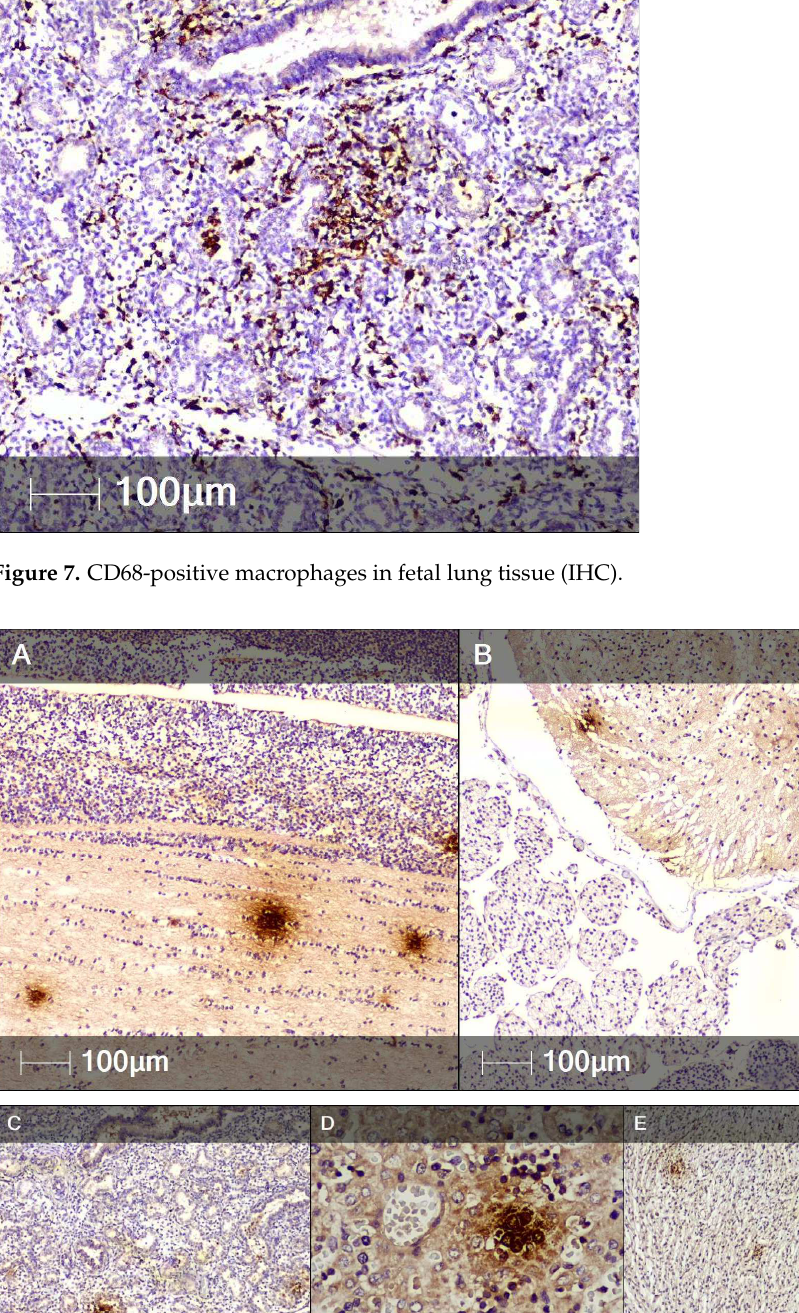
Figure 7. CD68-positive macrophages in fetal lung tissue (IHC).